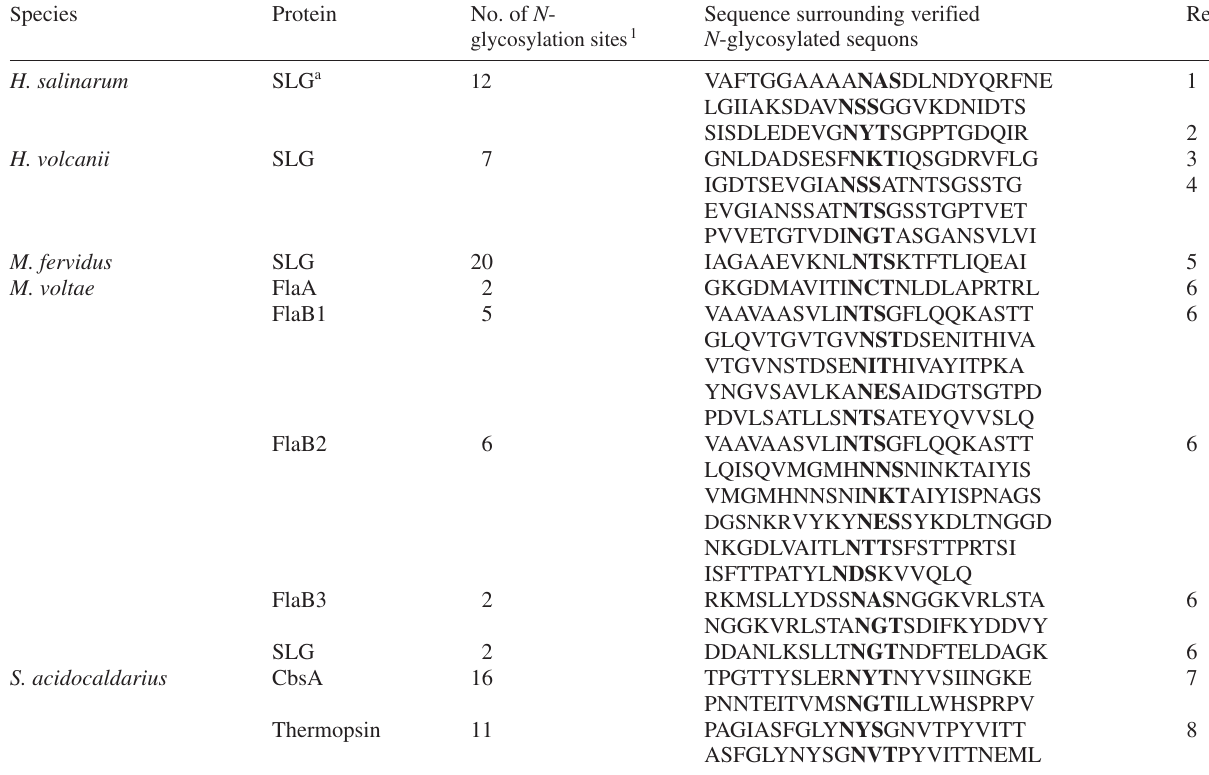
Table 1. Neighboring residues of experimentally verified N -glycosylated sequons in Archaea. References: 1 = Paul et al. 1986; 2 = Lechner and Sumper 1987; 3 = Sumper et al. 1990; 4 = Mengele and Sumper 1992; 5 = Brockl et al. 1991; 6. Voisin et al. 2005; 7 = Zahringer et al. 2000;